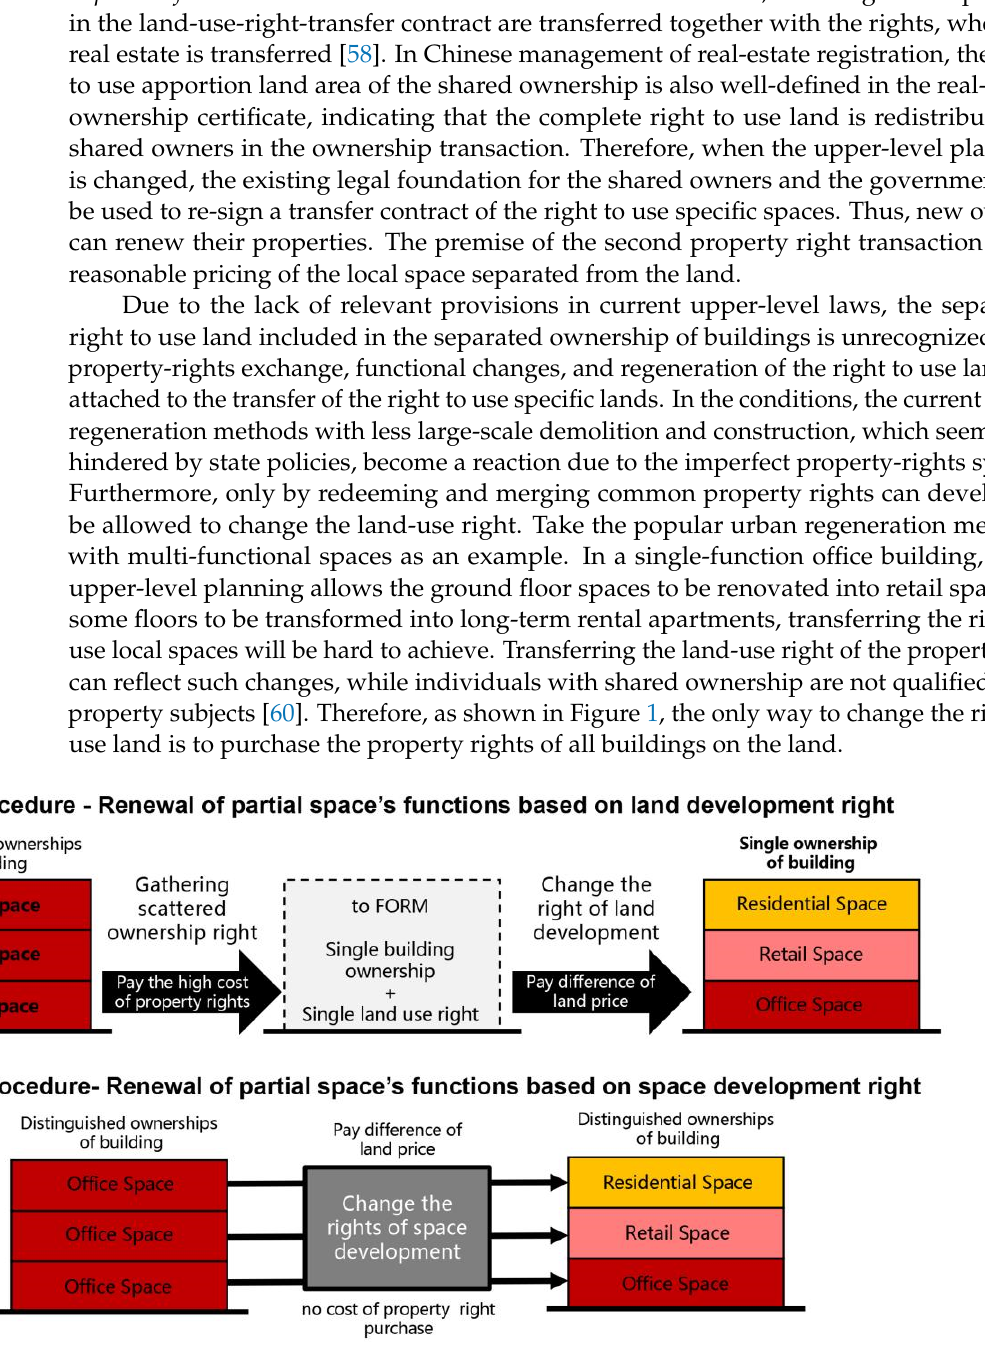
Figure 1. Procedure of function renewal based on different property rights objects (source: authors).